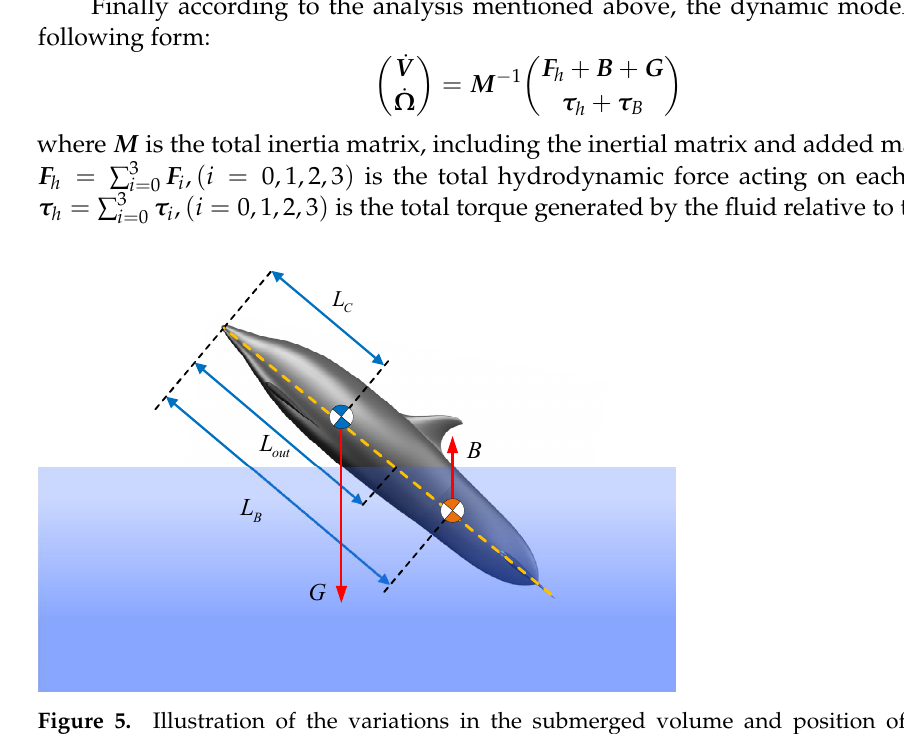
Figure 5. Illustration of the variations in the submerged volume and position of the center of buoyancy.